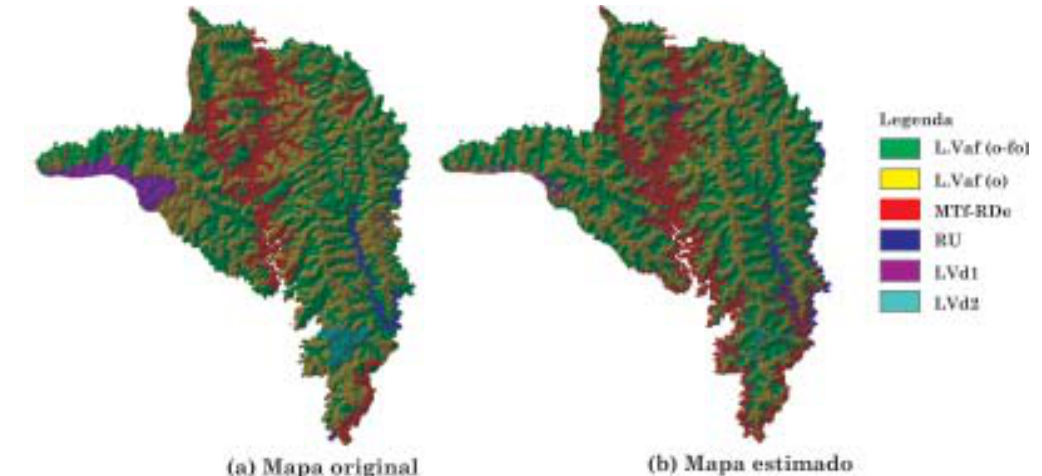
Figura 1. Mapas de solos: original (a) e e estimado por regressões logísticas (b) nos municípios de Ibirubá e Quinze de Novembro